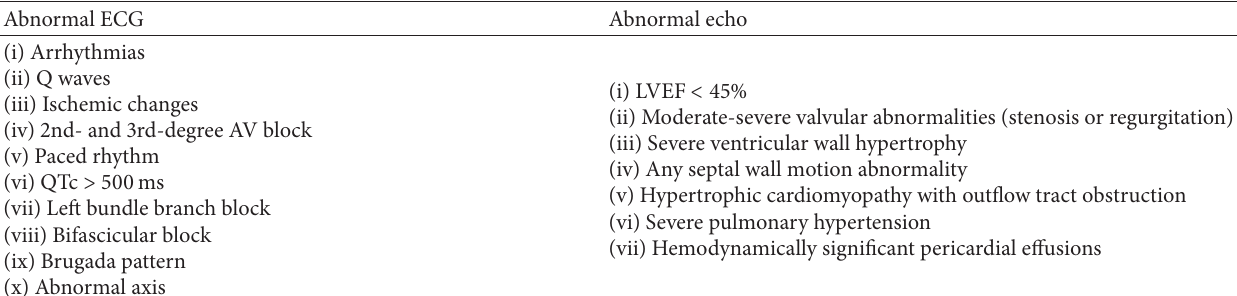
Table 1: Definitions of abnormal ECG and